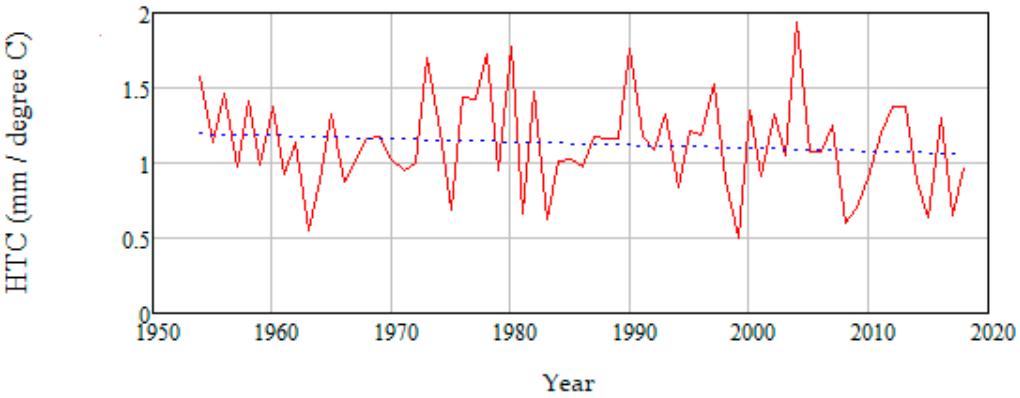
Figure 3. The values of HTC (mm ◦ C − 1 ) from 1954 to 2018 for the Belgorod Region. The blue dashed line is the linear trend line (mm ◦ C − 1 ).